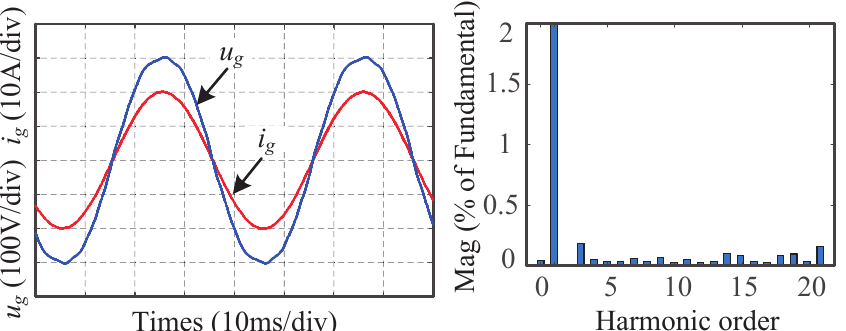
Figure 17. Output waveforms of the FA-IRC system and spectrum analysis of the output current when f g = 49.6 Hz.